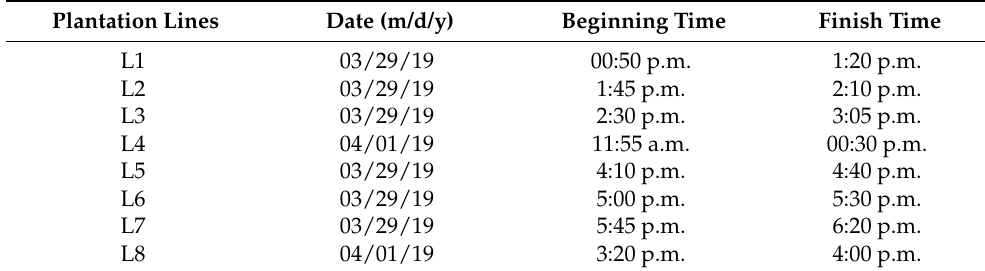
Table 1. Information on date, beginning and finish time of images